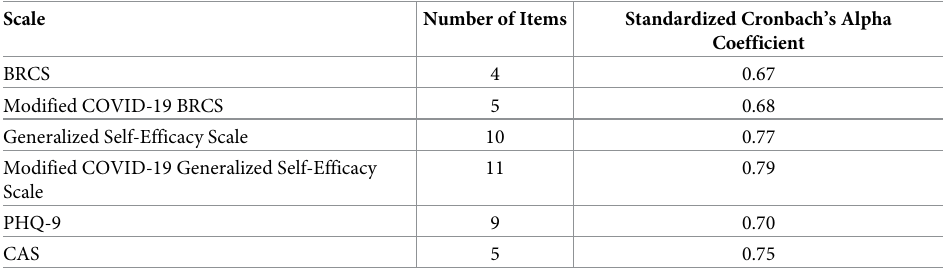
Table 3. Internal reliability estimates for included